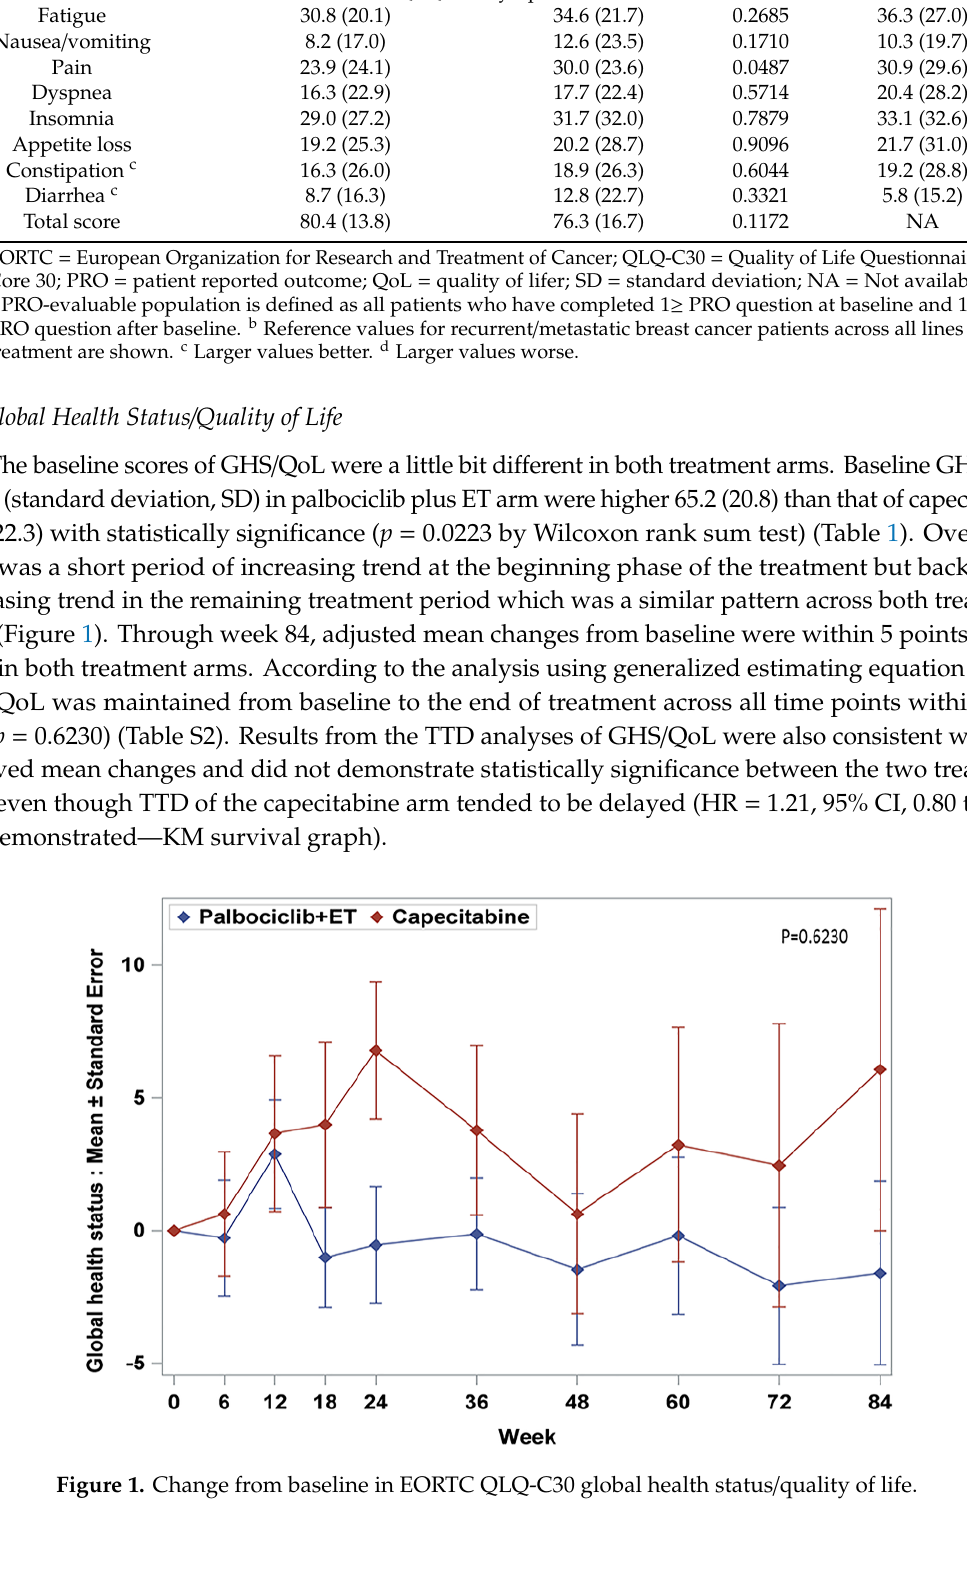
Figure 1. Change from baseline in EORTC QLQ-C30 global health status/quality of life.